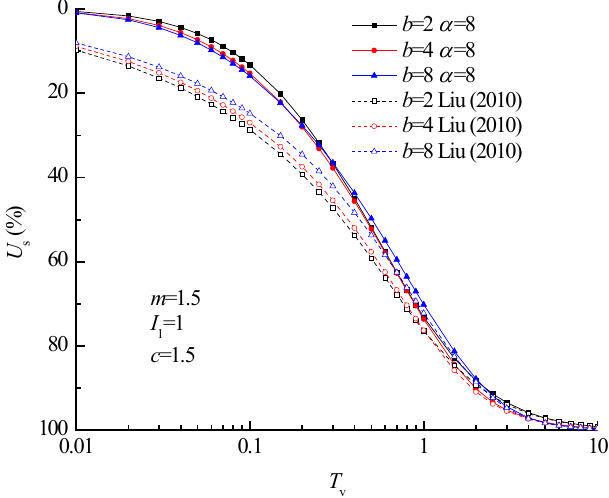
Figure 12. Influence of the b value on ACDS ( m = 1.5, c = 1.5) [23].